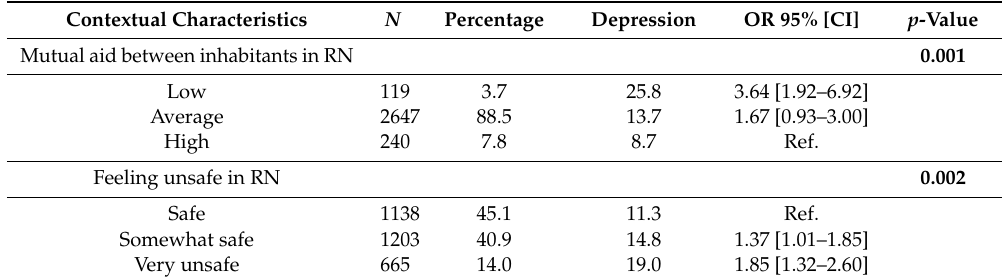
Table 2. Univariate analysis of the associations between contextual neighborhood characteristics and depression, SIRS, 2010.